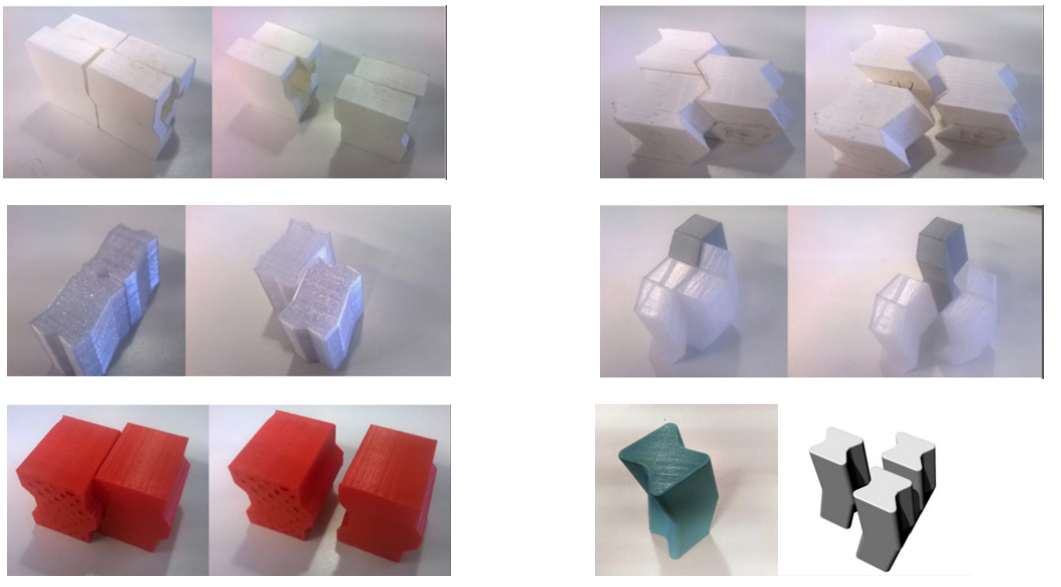
Fig. 9 Prototypes for shape exploration